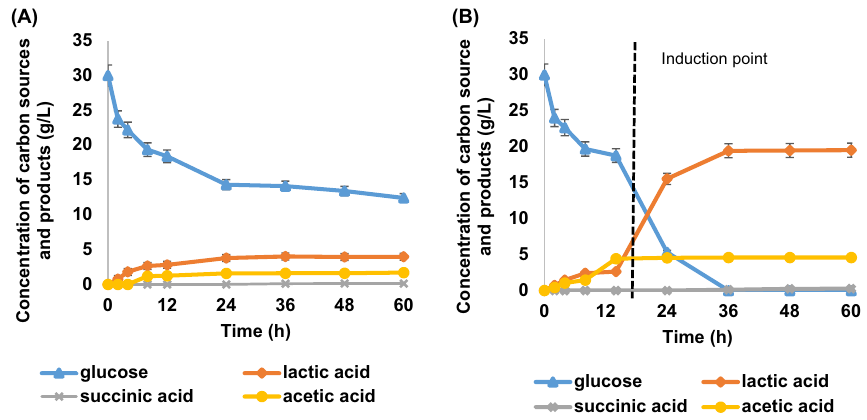
Figure 7. Lactic acid concentration and sugar consumption by A. succinogenes at different carbonate loading with ( A ) 20 g/L of Na 2 CO 3 loading, and ( B ) 30 g/L of MgCO 3